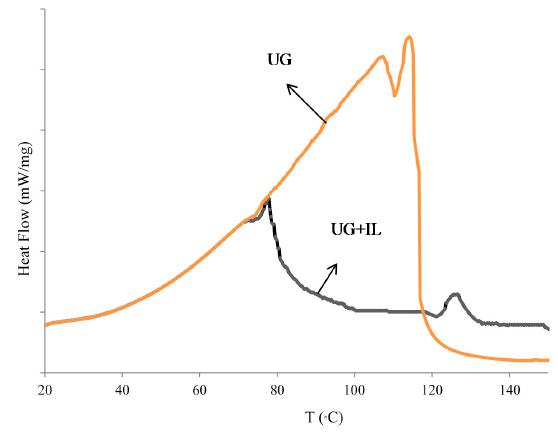
Figure 4. DSC curve of the UG resin and UG resin + 2% ILs.